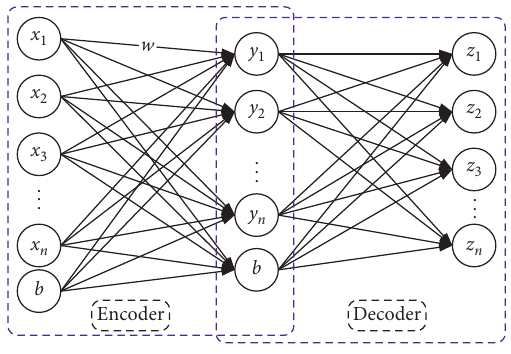
Figure 1: Structure of